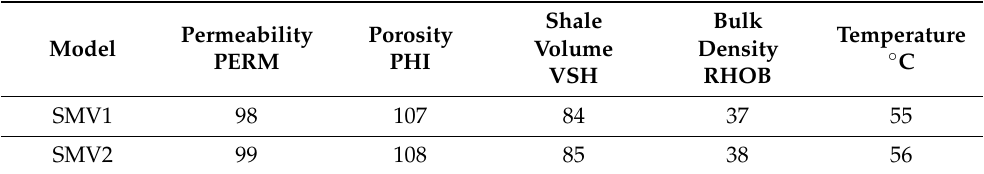
Table 4. Input data for parametric modeling in variant 1 (in structural framework SMV1) and variant 2 (in structural framework